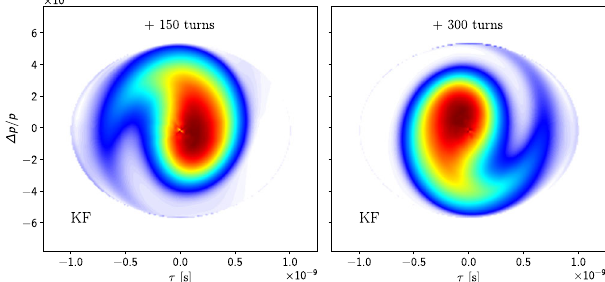
FIG. 5. Kalman filter phase-space reconstruction of the addi- tional turns. Input longitudinal profiles based on the Monte Carlo simulation.